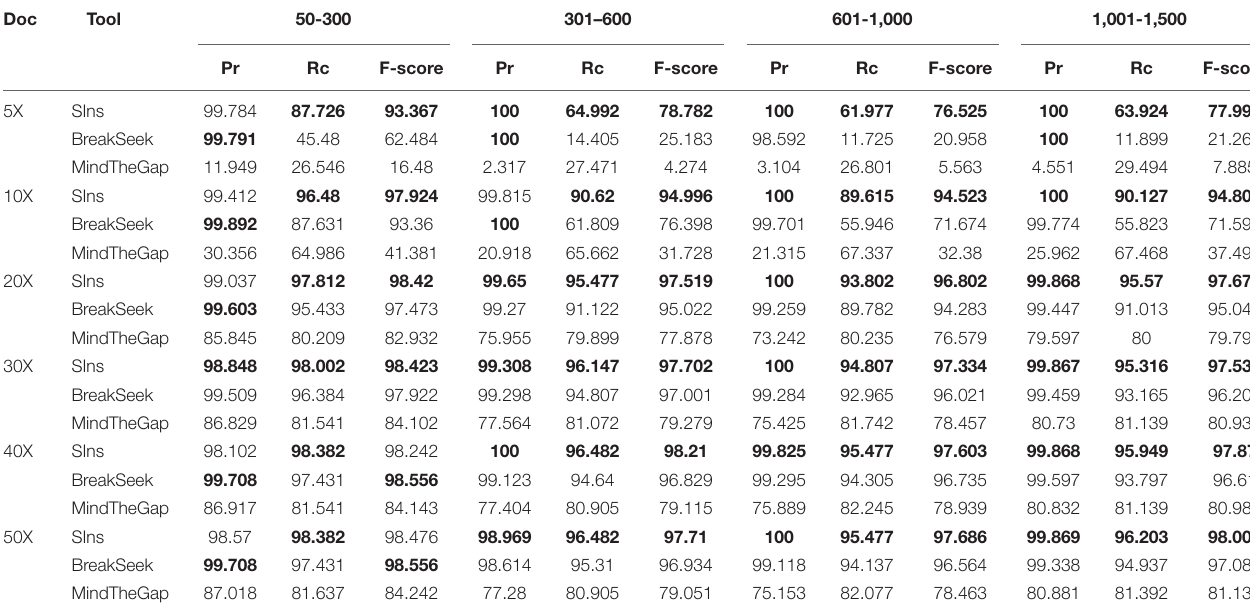
TABLE 1 | Comparison of three tools for four